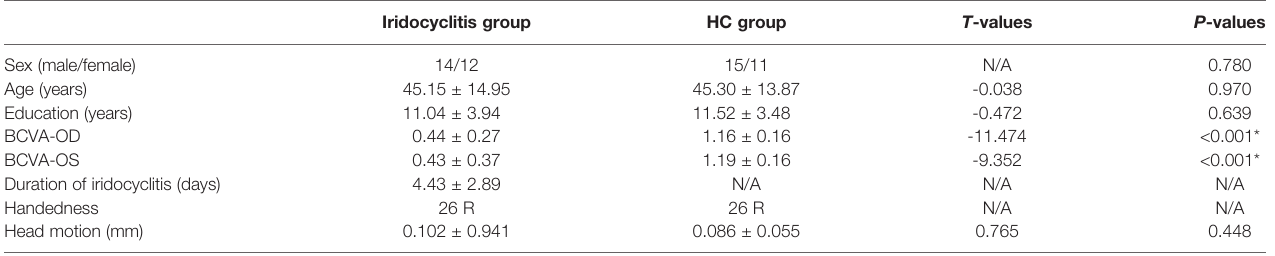
TABLE 2 | Clinical characteristics for patients with iridocyclitis and